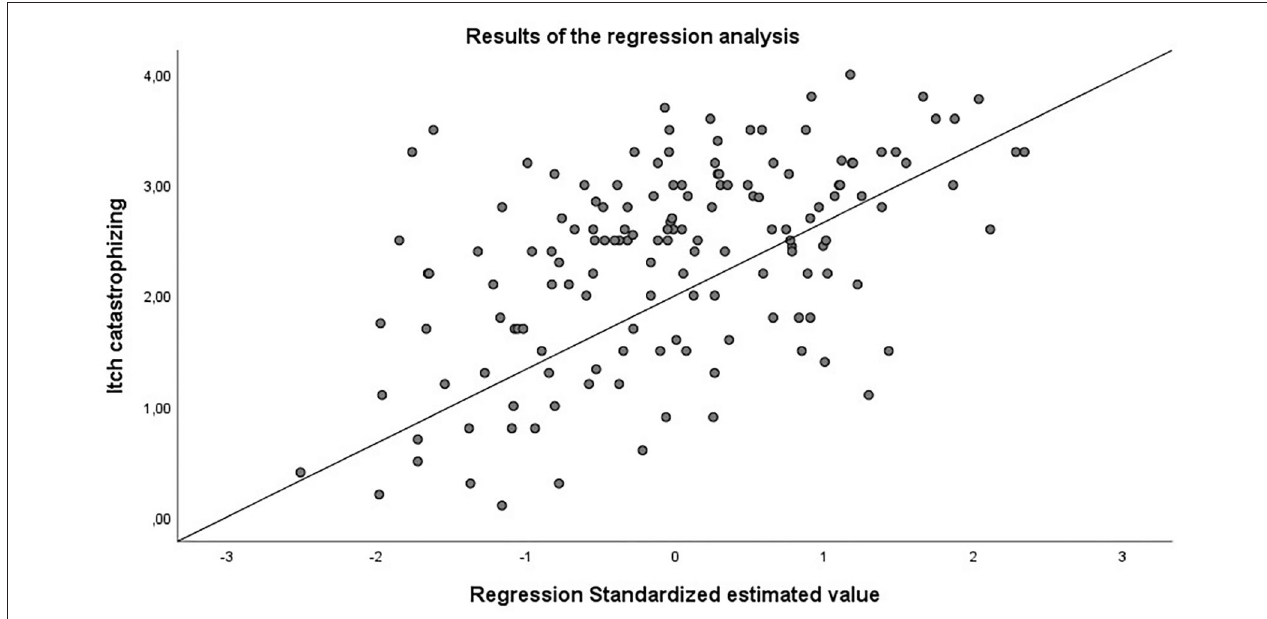
FIGURE 1 | Results of the regression analysis. 27.4% of itch catastrophizing could be explained by itch intensity during the last 2 weeks and the mindfulness scale “acting with awareness”.